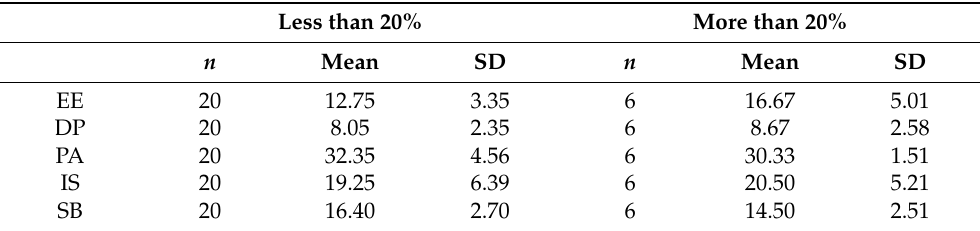
Table 10. Results of the MBI dimensions by weight of income by tutorial